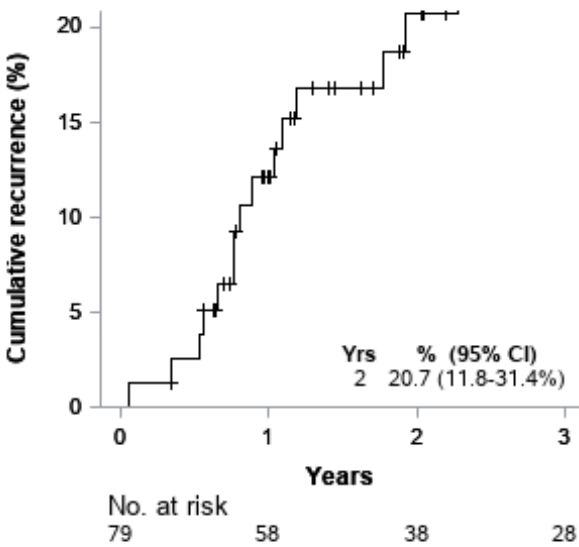
Figure 4. Cumulative incidence of distant recurrence. Table 4. Univariate Cox models for OS.